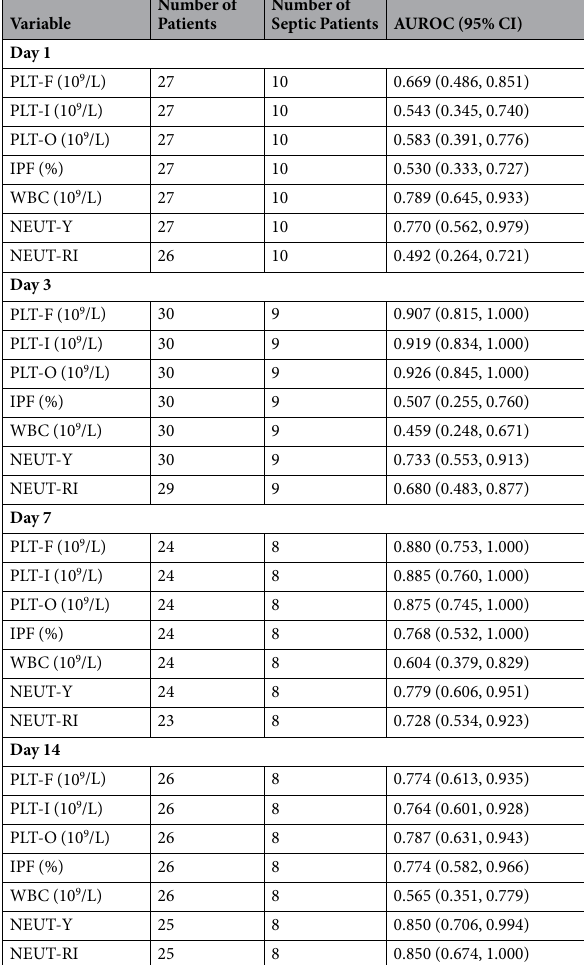
Table 2. Discriminatory power of platelet fluorescence count (PLT-F), platelet impedance count (PLT-I), platelet optical count (PLT-O), immature platelet fraction (IPF), white blood cell count (WBC), NEUT-Y and NEUT RI for sepsis at different time points. Data was assessed through area under the receiver operating characteristic curve (AUROC) analysis and shown with 95% confidence